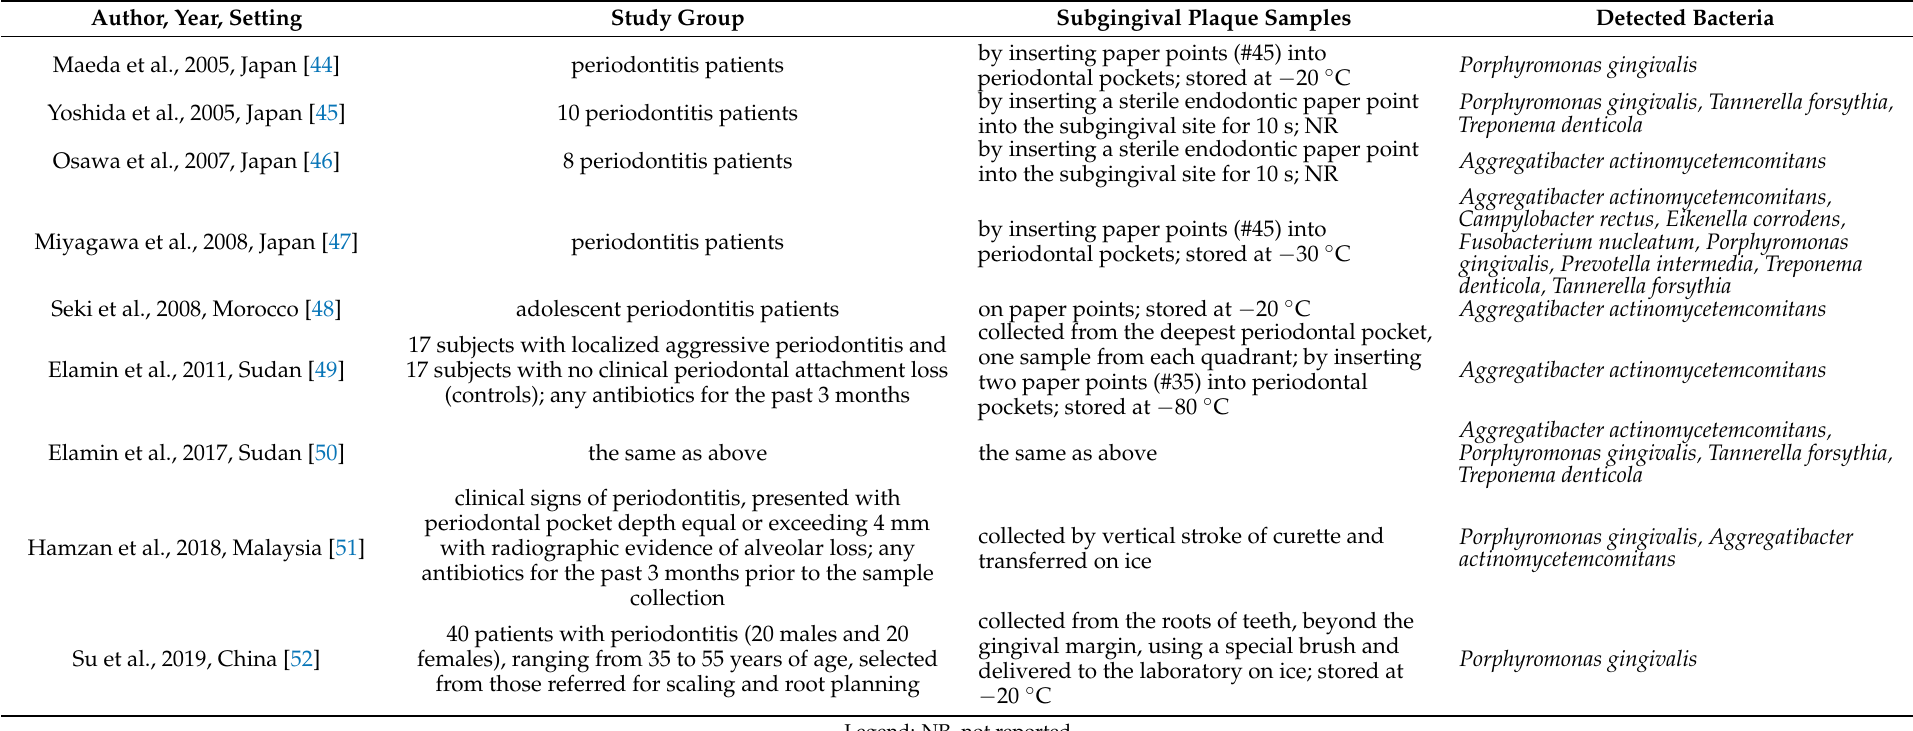
Table 1. General characteristics of included